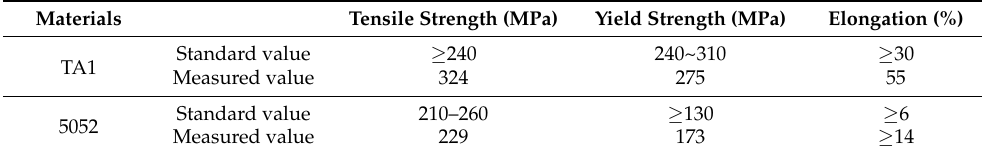
Table 2. Mechanical properties of TA1 and 5052 alloy